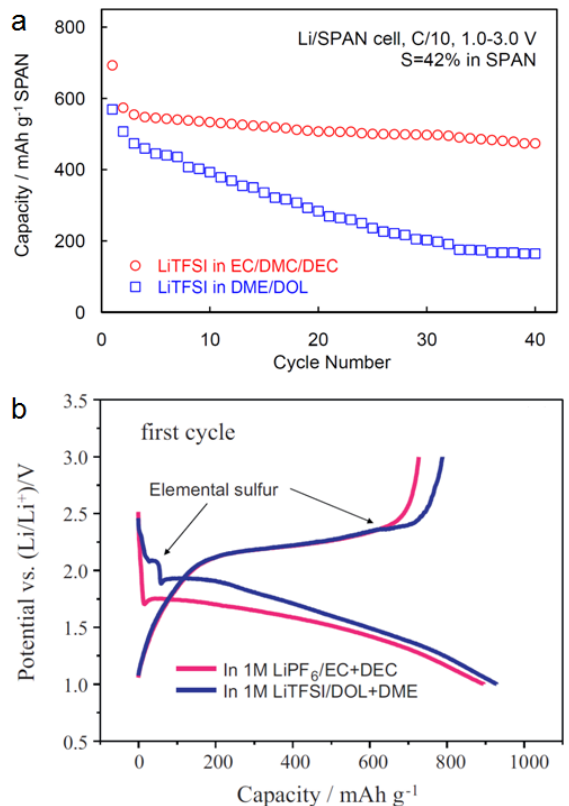
Figure 4. Effect of electrolyte solvents on the cycling performance of Li/SPAN cell (42% S in both SPANs). ( a ) capacity retention; and ( b ) voltage profile of the first cycle. Figure 4a was plotted from the data of [9] and Figure 4b is reproduced with permission of Elsevier from